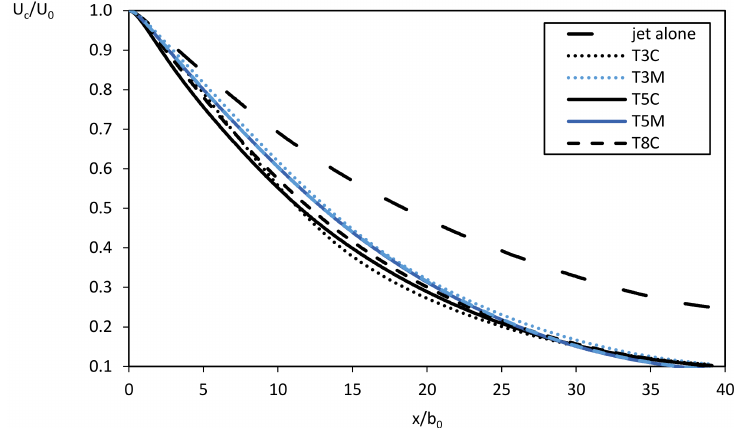
Figure 12. Normalized longitudinal velocity, along the jet centerline, in the case of jet alone and with the superimposed wave propagation with peak periods of 3 s, 5 s and 8